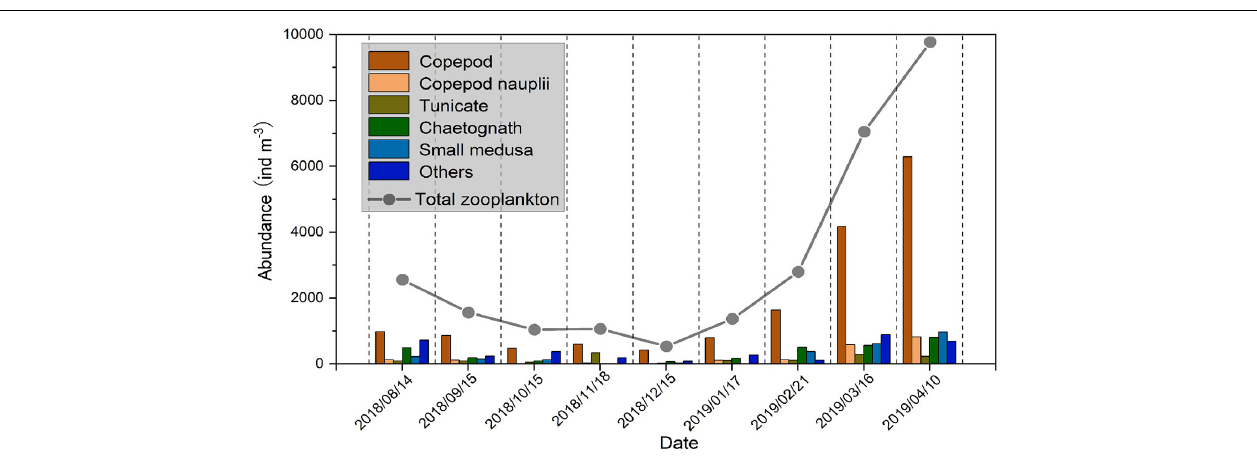
zooplankton abundance (ind m − 3 ). We considered P < 0.05